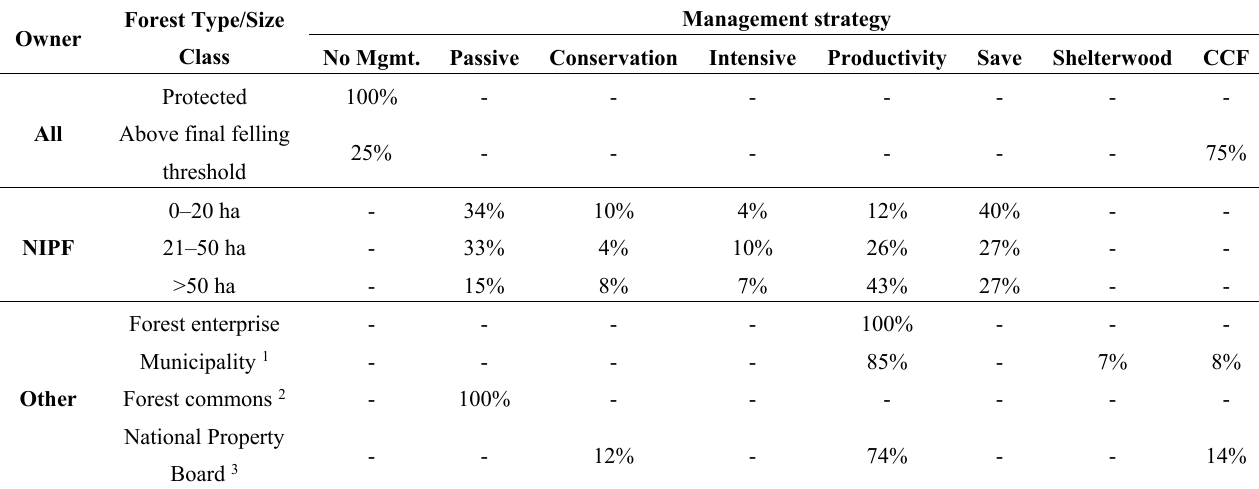
Table 5. Distribution of management strategies for the different owner and forest types in the Diverse scenario (Vilhelmina).